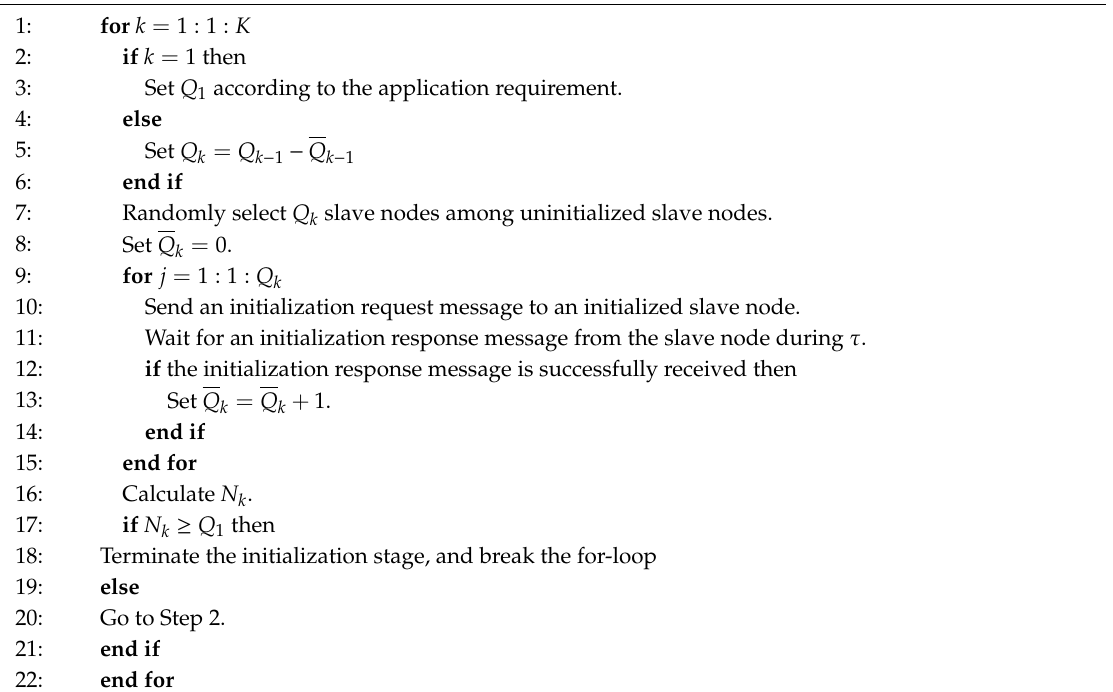
Algorithm 1 . The pseudo code of the algorithm for a master